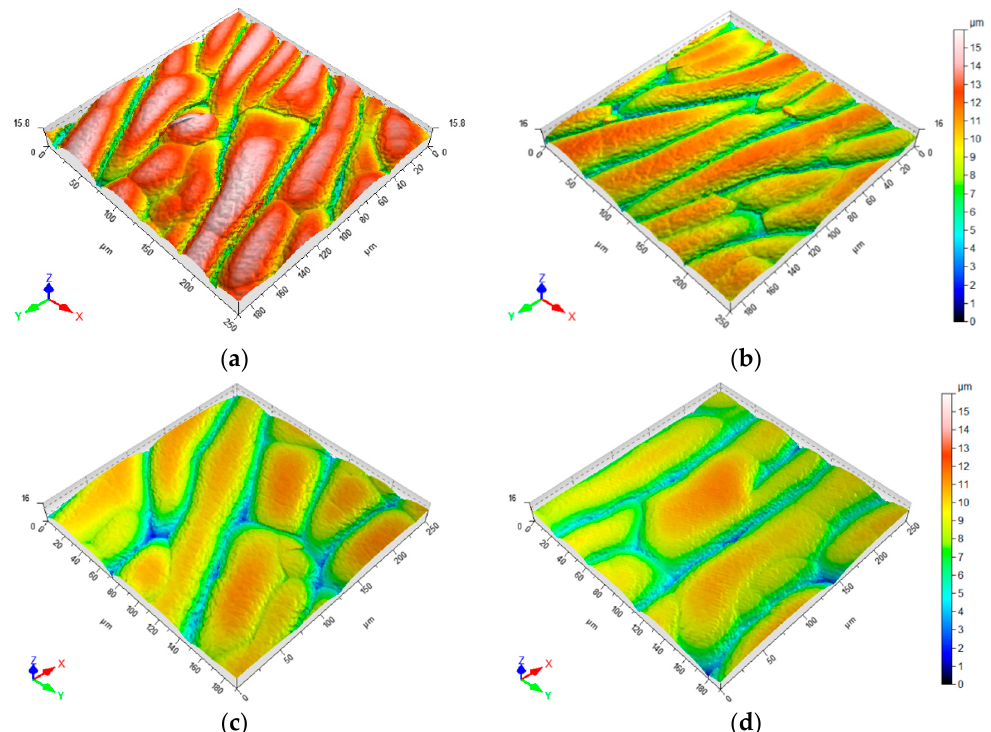
Figure 7. Surface plot of coated nitrile butadiene rubber (NBR) after deposition: ( a ) 1.5 phr; ( b ) 3 phr; ( c ) 6 phr; and ( d ) 9 phr sulfur content.